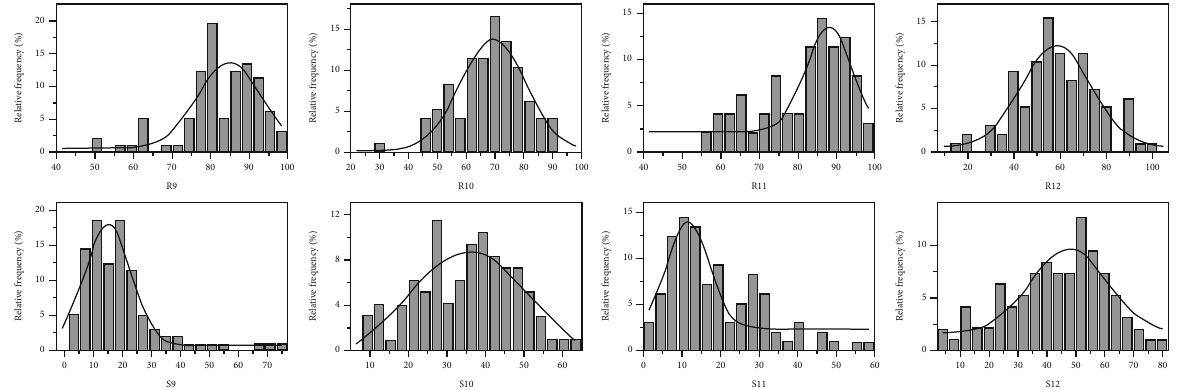
Figure 6: Probability density distribution of the random variables in e ff ect of the engineering geology practice ( R 9 – R 12 , S 9 – S 12 ).